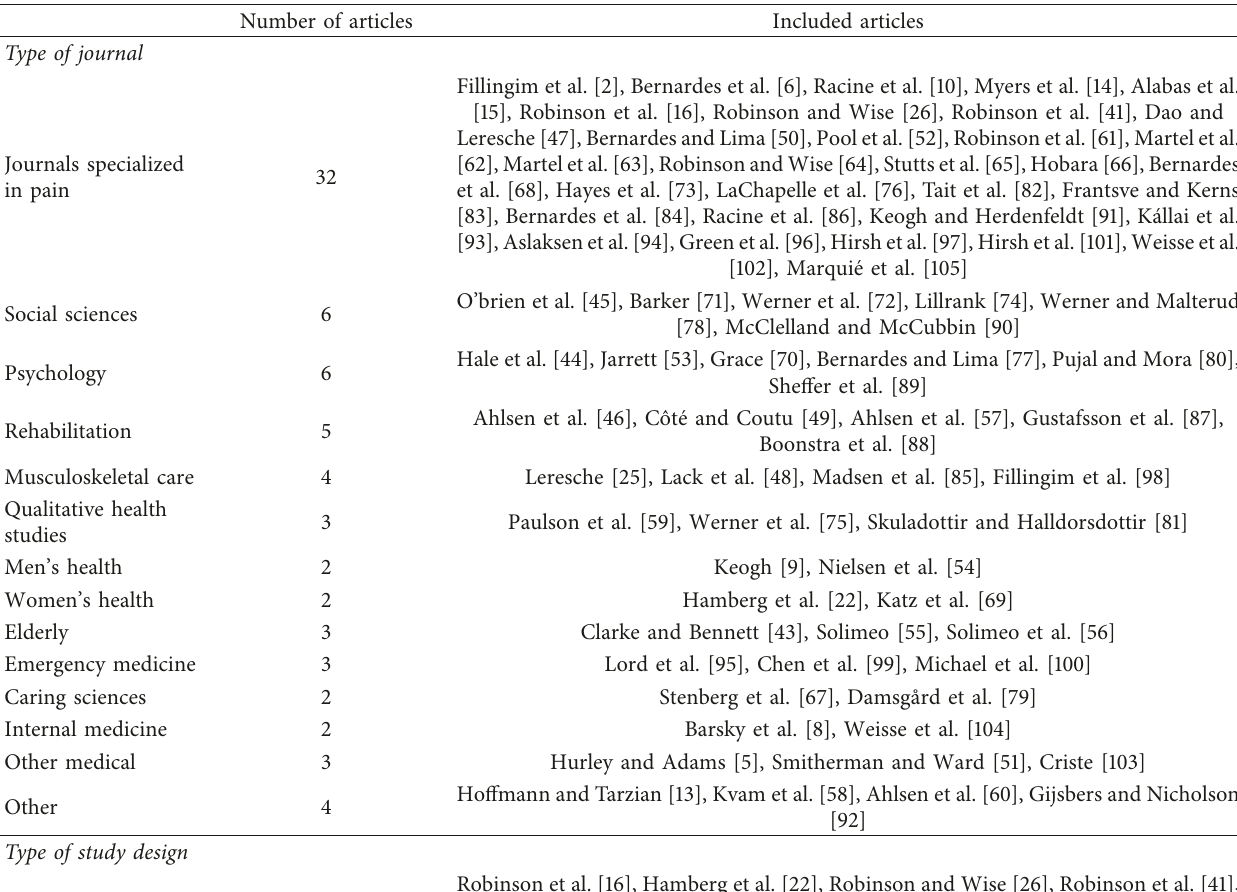
Table 1: Included articles, sorted by type of journal and type of study